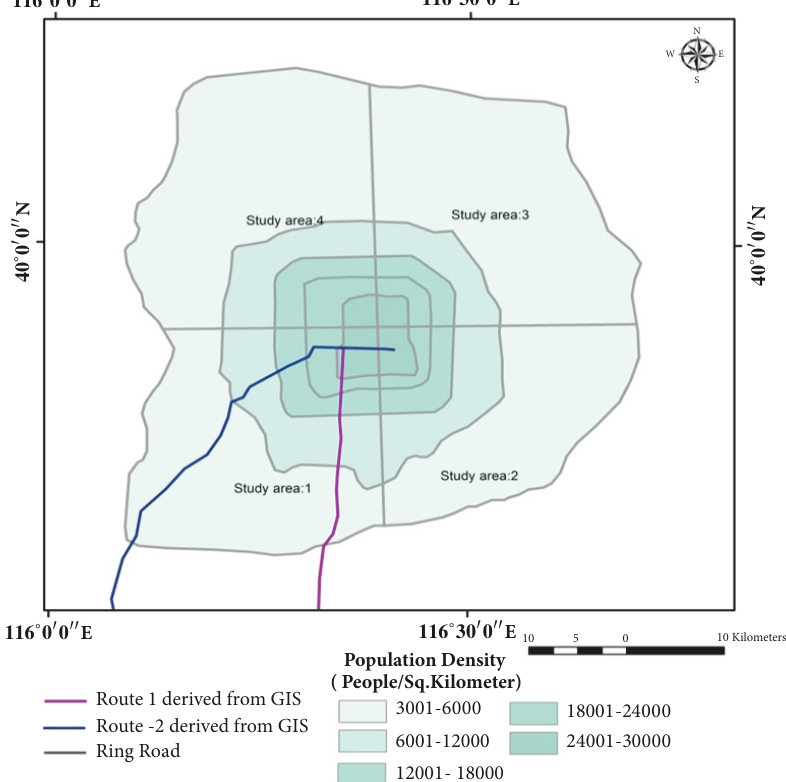
Figure 2: Distribution of Beijing city on the basis of population and ring road.